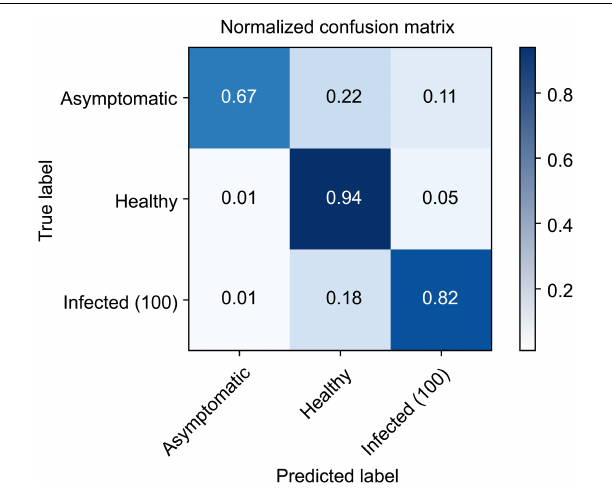
FIGURE 12 | Confusion matrix results from the trained Resnet-50 model to infer the test set.